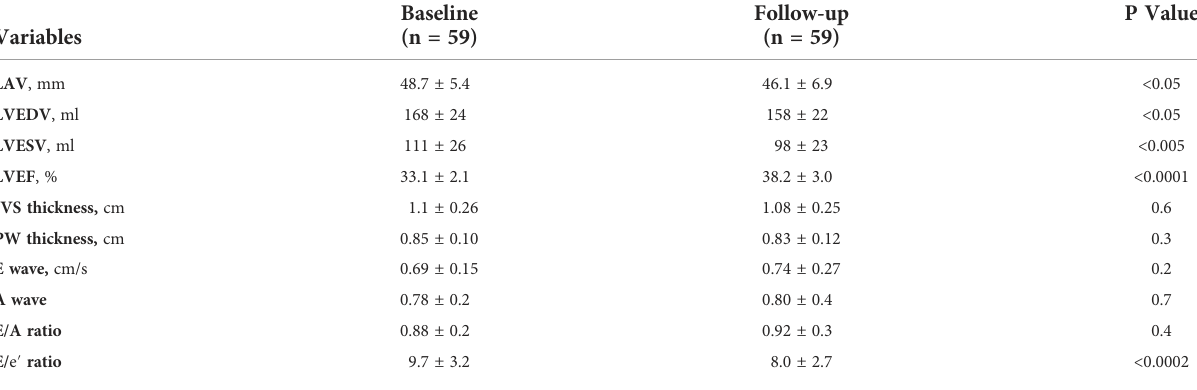
TABLE 4 Echocardiographic parameters at baseline and after 24 weeks of therapy with